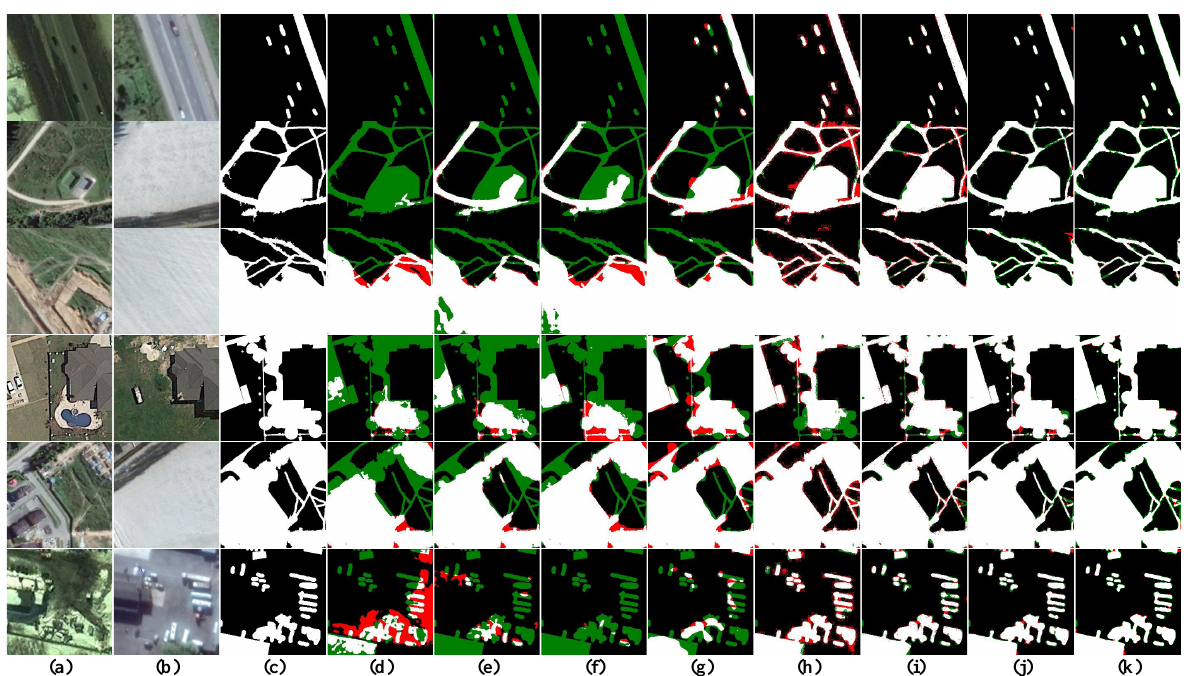
Figure 8. Visualization results on the CDD dataset. ( a ) T1 images. ( b ) T2 images. ( c ) Ground Truth. ( d ) FC-EF. ( e ) FC-Siam-conc. ( f ) FC-Siam-diff. ( g ) CDNet. ( h ) STANet. ( i ) BIT. ( j ) SNUNet. ( k ) Ours. White indicates correctly detected changed areas, black indicates correctly detected unchanged areas, red indicates incorrectly detected unchanged areas as changed areas, and green indicates unpredicted changed